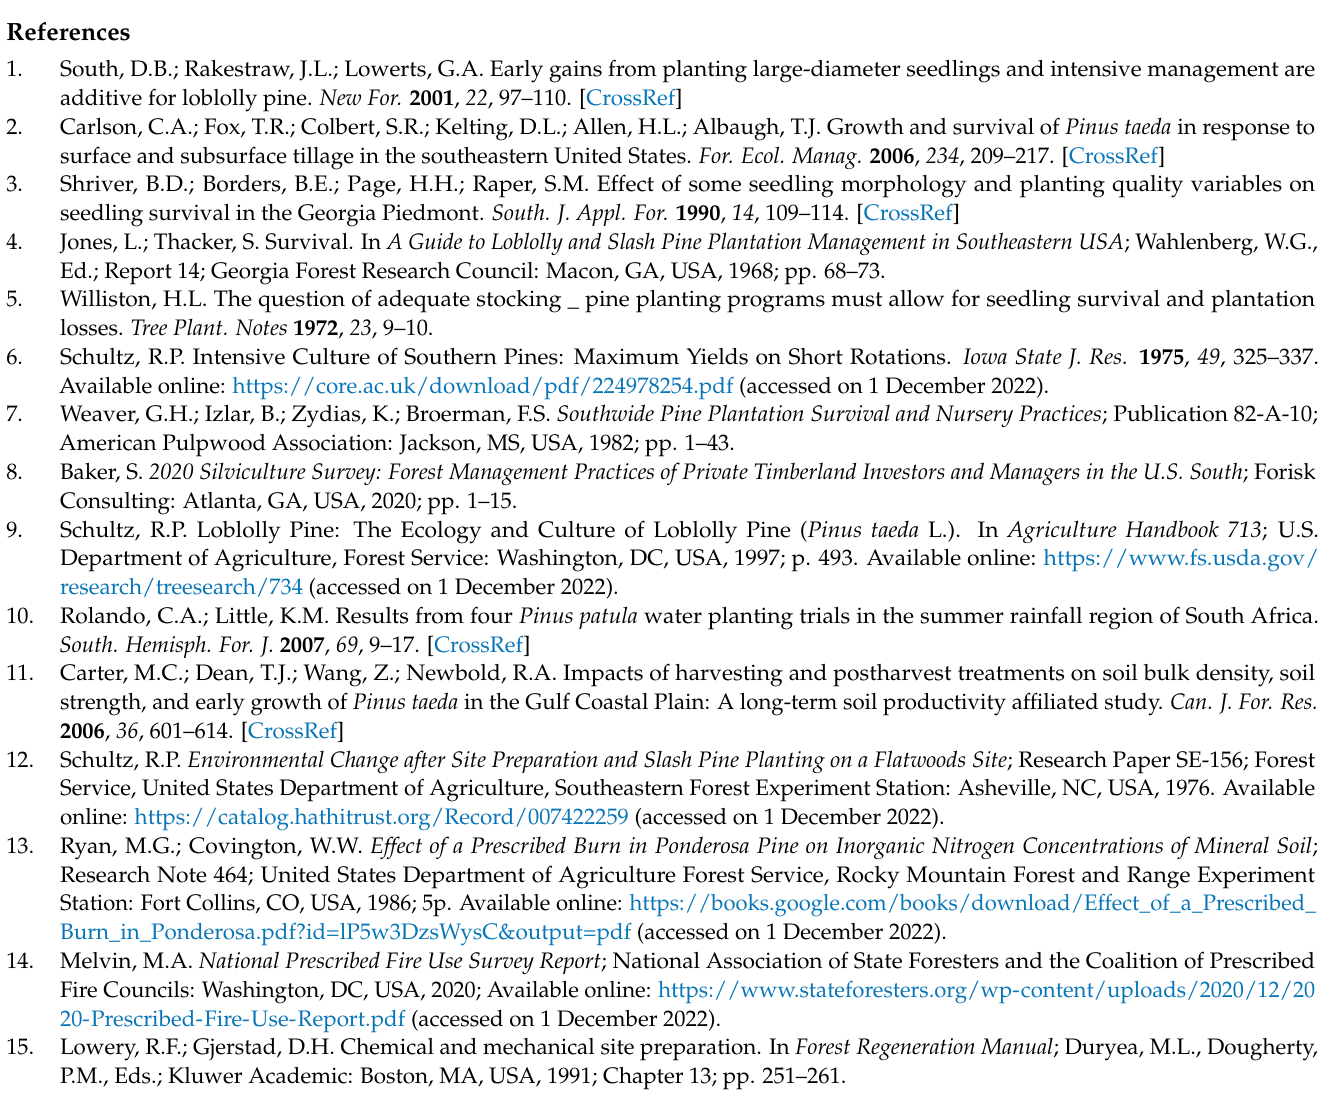
Figure A1. A regeneration survey (>4700 ha) indicates 90% of planted upland areas had more than 200 naturally seeded pines ha − 1 . As a result, precommercial thinnings are used so managers can harvest a high percentage of genetically improved stock at the end of the rotation. In 2019, over 24,000 ha of stands were precommercially thinned [8].